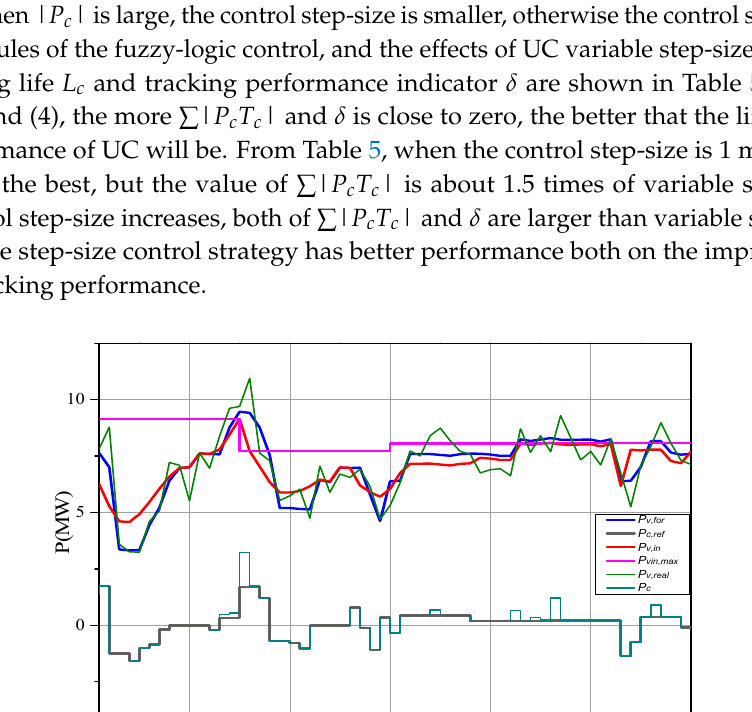
Figure 8. Results of UC control and real-time adjustment.